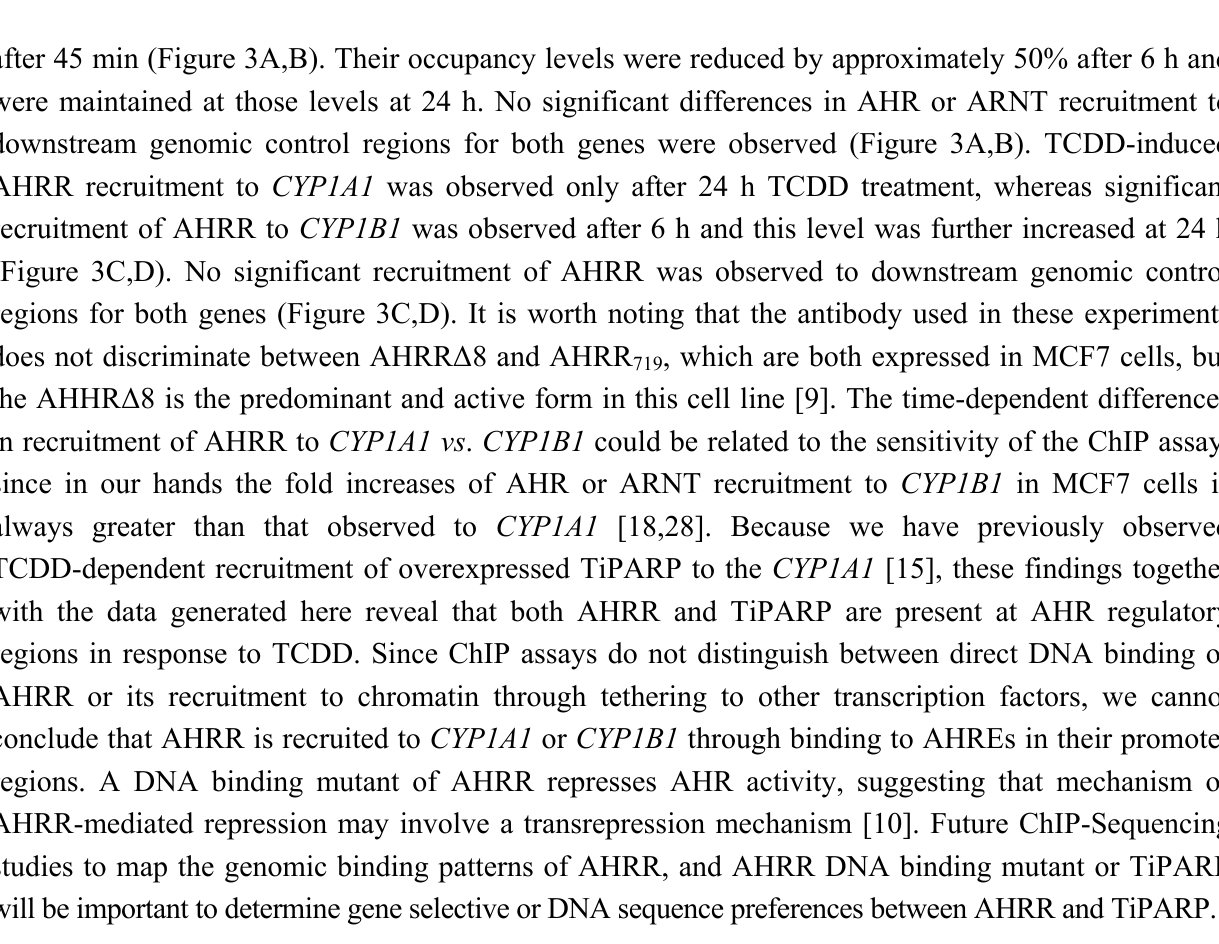
Figure 3. TCDD-induced recruitment of AHR, ARNT and AHRR to CYP1A1 and CYP1B1 . Recruitment of ( A , B ) AHR, ARNT and ( C , D ) AHRR to CYP1A1 and CYP1B1 regulatory and distal downstream regions was determined using ChIP assays done on MCF7 cell extracts. Data were presented as means ± SEM from three independent experiments. Recruitment levels significantly different ( p < 0.05) than 0 h were